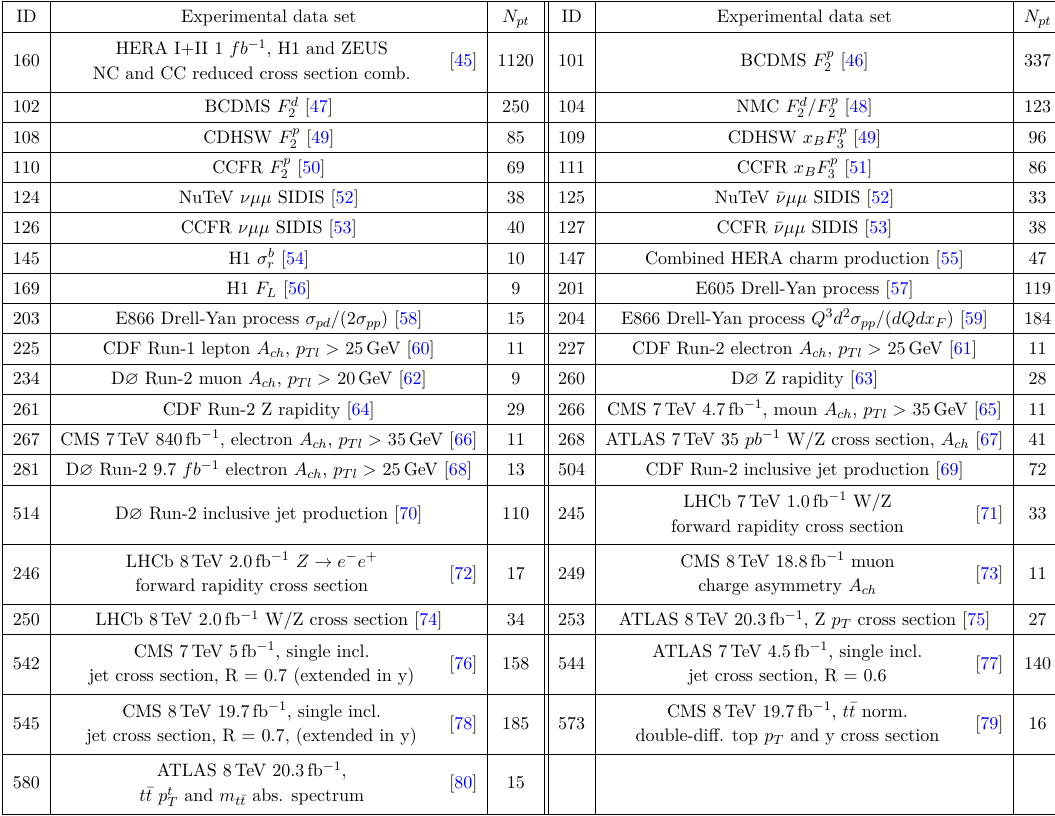
Table 2 . Experimental data sets involved in the global fit